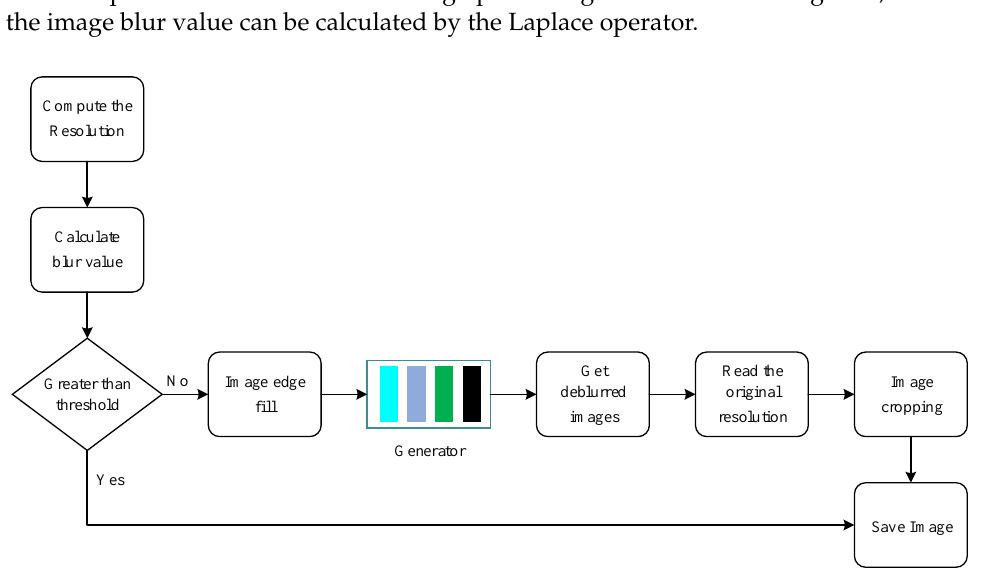
Figure 1. Motion-blurred-image processing flow.